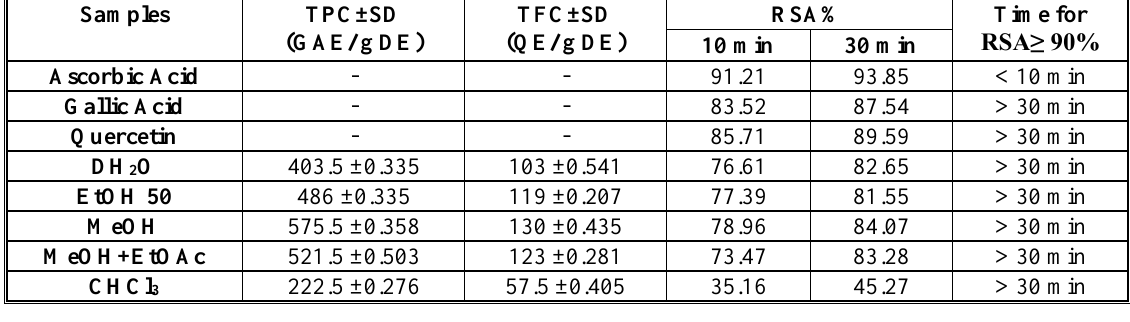
Scanning of extract solution The scanning of the extract solution is shown in Figure (4) , it indicates that the extract of E. polyceras roots is free of ascorbic acid.